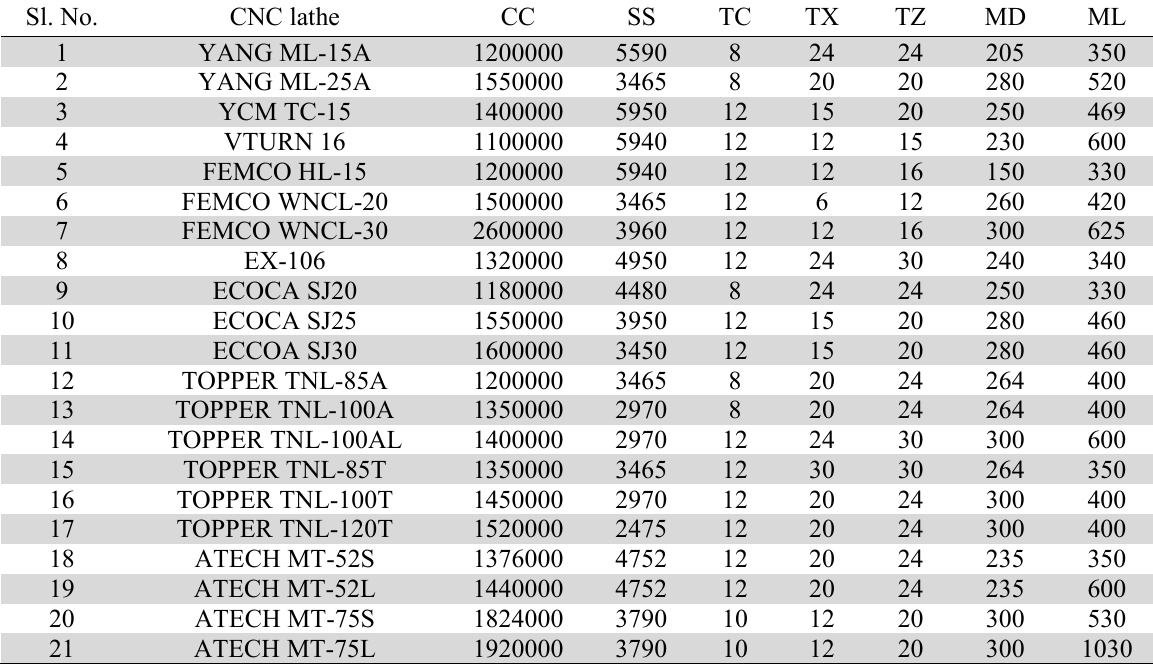
Quantitative data for machine tool selection problem (Sun, 2002) Sl. No.